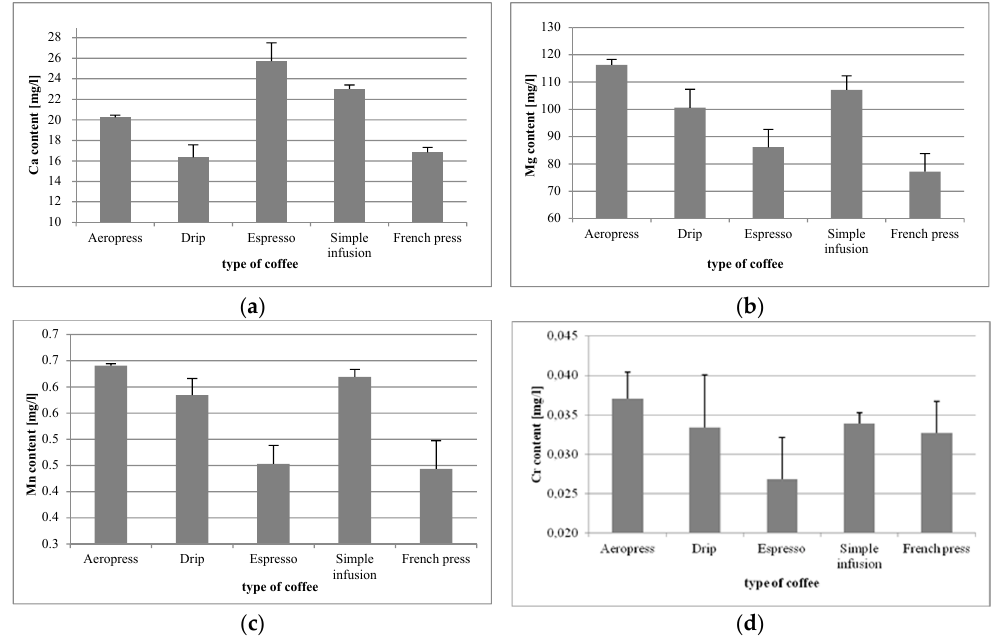
Figure 1. Concentrations of Ca ( a ), Mg ( b ), Mn ( c ), and Cr ( d ) in coffee beverages made using different methods.